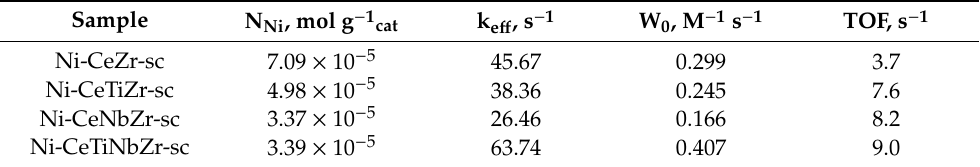
Table 6. Kinetic parameters of DRM